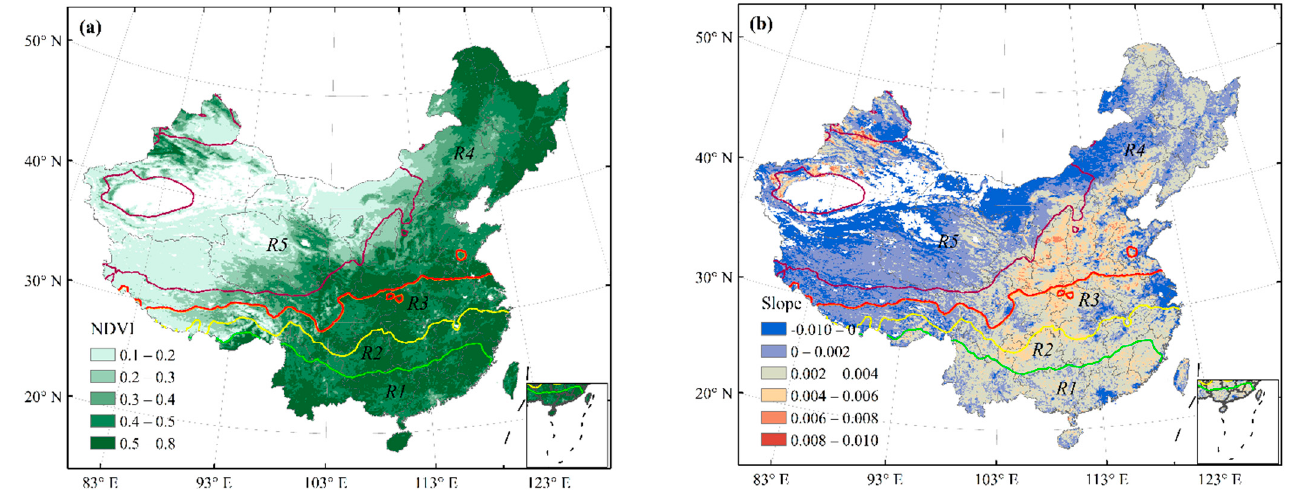
Figure 4. ( a ) Spatial distribution of multiyear average NDVI during 1982–2020 and ( b ) spatial distribution of the rate of NDVI change. The colored lines from south to north refer to the contour lines of OMR values of 650, 700, 750 and 800 kg/kg, respectively. The author used the software of ArcGIS 10.5 to produce the figure.